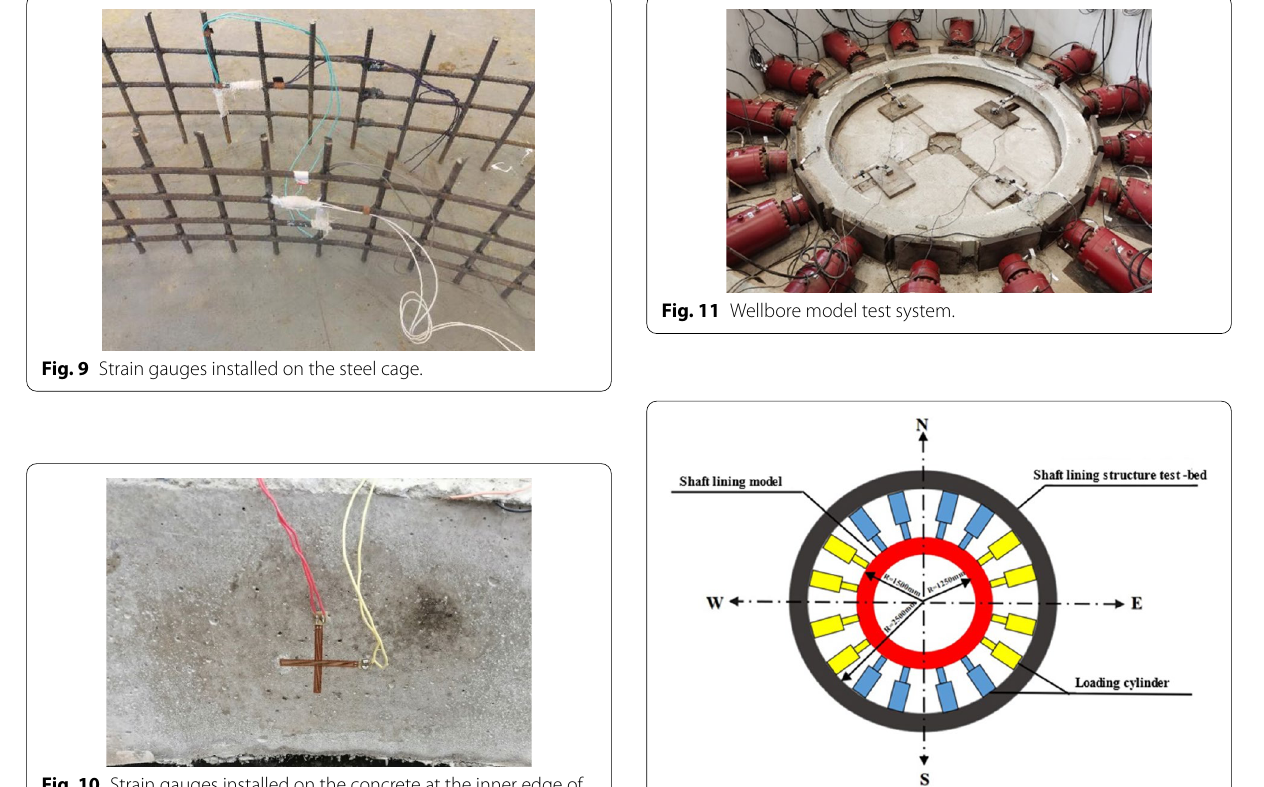
Fig. 12 Schematic of model test loading.